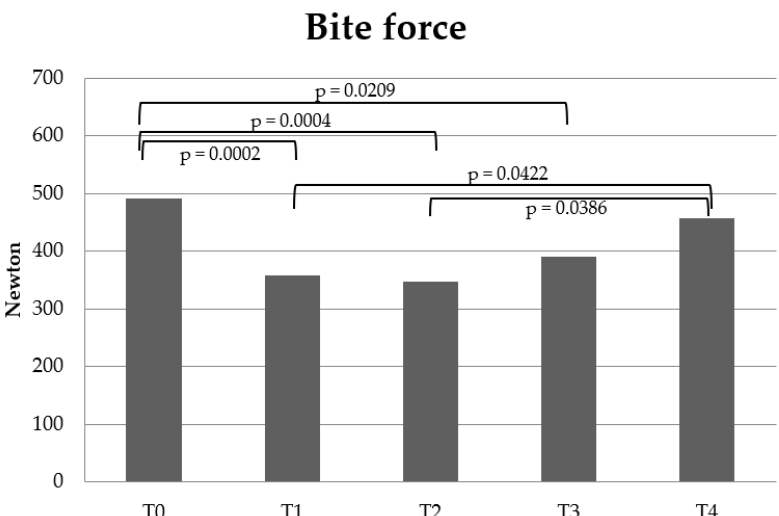
Figure 3. Bite force changes. The chart shows the mean bite force at the different treatment phases: Pre-treatment (T0), 1st follow-up after bonding fixed appliance (T1), during treatment (T2), post- treatment (T3) and at 1st retention follow-up (T4). The significant p -values are shown tested by a mixed-model post hoc test (Bonferroni).